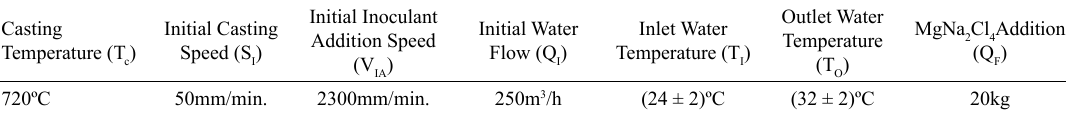
Table 1. Casting parameters that were held constant during plates manufacturing.